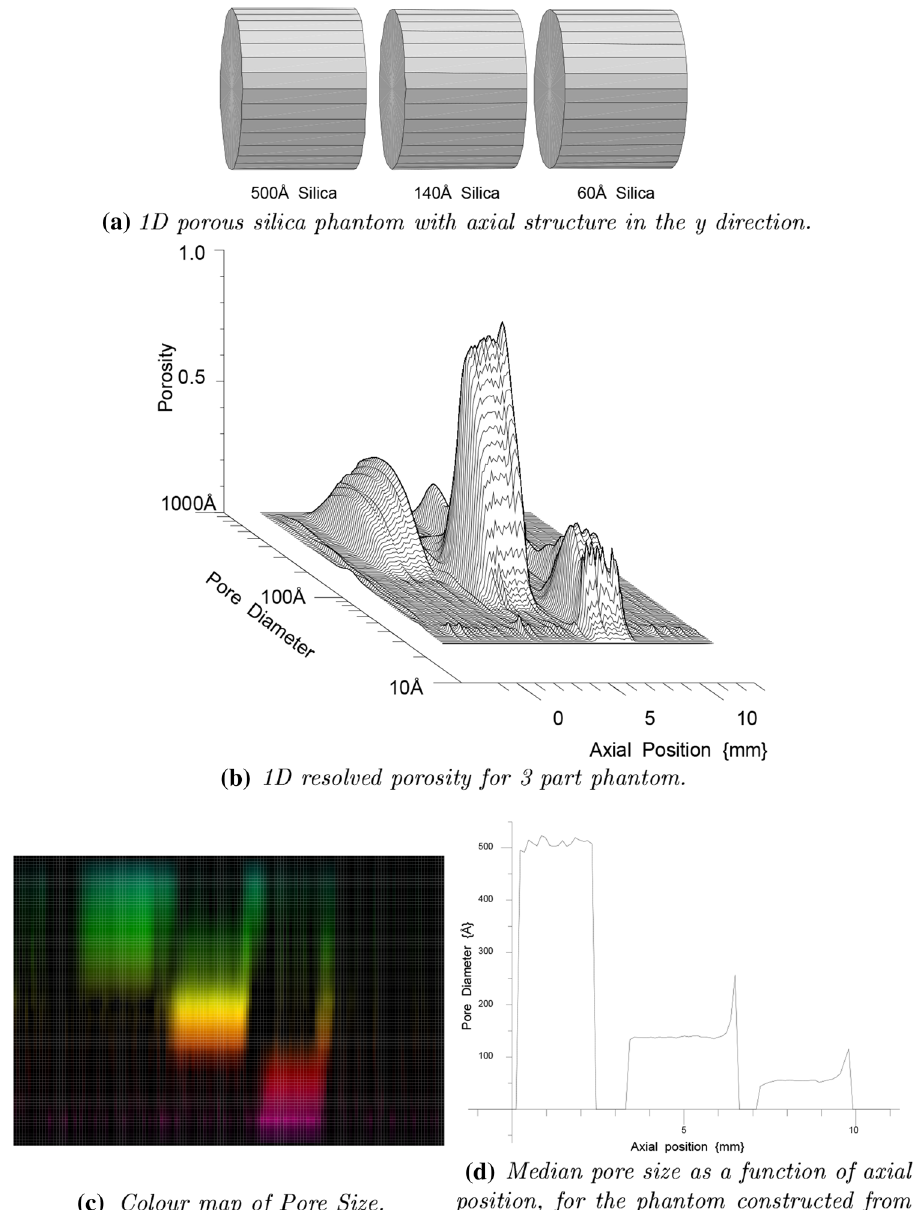
Fig. 26 1 D spatially resolved pore sizes—3 different sol-gel silicas separated by Teflon spacers, in a 5mm diameter NMR